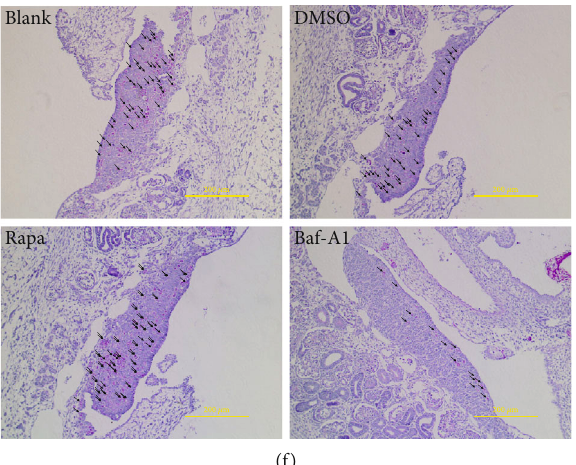
Figure 5: Baf-A1 inhibited the formation of PGCs in vivo. (a, b) After rapamycin (autophagy activator) or Baf-A1 (autophagy inhibitor) was injected in vivo, the expression of p62 and LC3B was detected using qRT-PCR and western blot. (c, d) The expression of reproductive marker genes was detected using qRT-PCR. (e) After labelling positive cells with CVH (PGCs speci fi c protein), the e ffi ciency of PGCs formation after autophagy activation or inhibition in vivo was detected by fl ow cytometry. (f) After rapamycin (autophagy activator) or Baf-A1 (autophagy inhibitor) was injected in vivo, the number of PGCs in chicken embryos between groups was calculated using glycogen staining of para ffi n sections. Scale bar = 200 μ